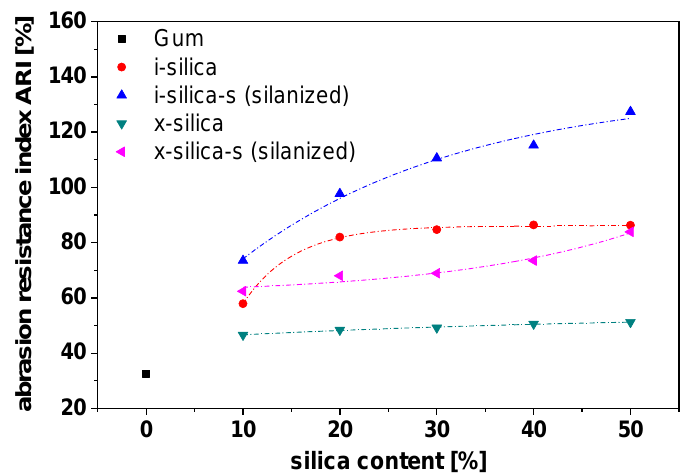
Figure 6. ARI of gum, in-situ, and precipitated silica compounds and its TESPT modified SSBR composites.